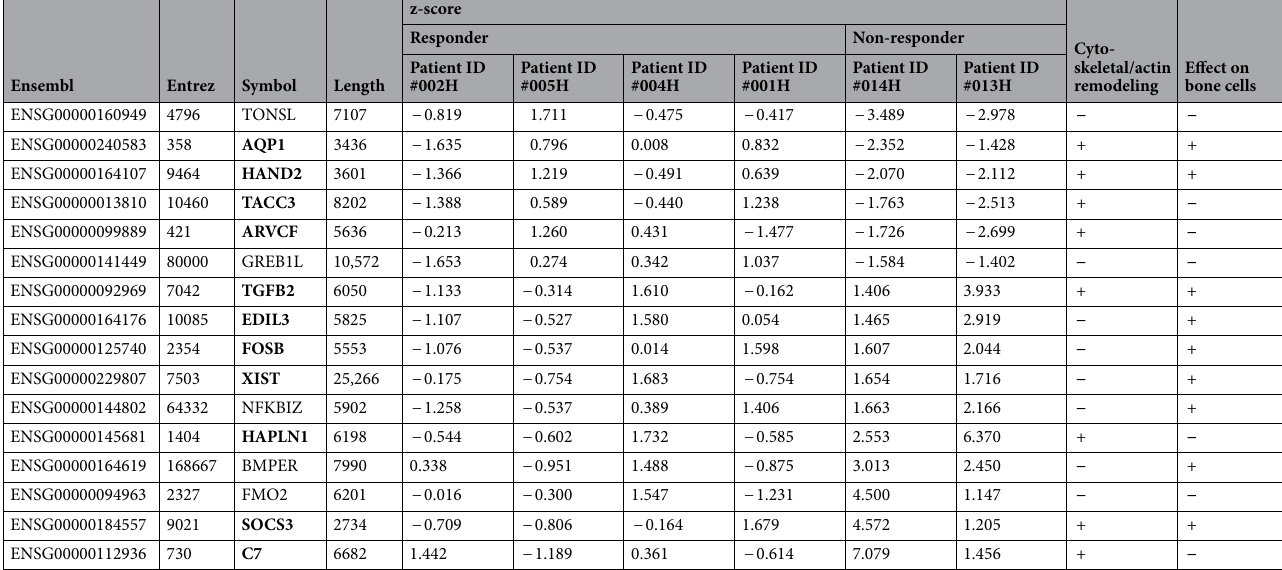
Table 3. Z-score of genes identified by next generation RNA sequencing with the strongest downregulated and upregulated genes in non-responding patients and their affiliation with either cytoskeleton arrangement and actin remodeling or influencing osteoblast/osteoclast activity or differentiation. Genes marked in bold were chosen for RT-qPCR